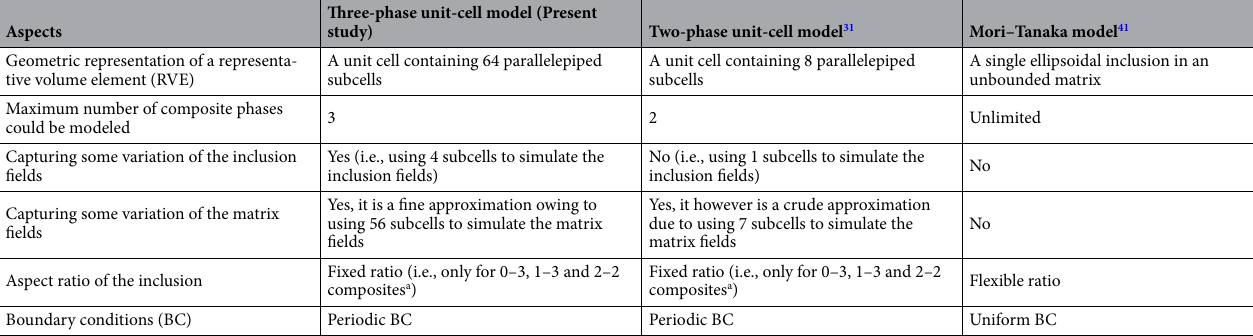
Table 1. Comparison between the present model and some micromechanics models in terms of 0–3 connectivity type. a In present study, 0–3 connectivity means that cubic particles are embedded in a matrix; 1–3 connectivity stands for that continuous fibers having square cross sections are embedded in a matrix; 2–2 connectivity represents that a bilaminated composite having rectangular cross sections for its two